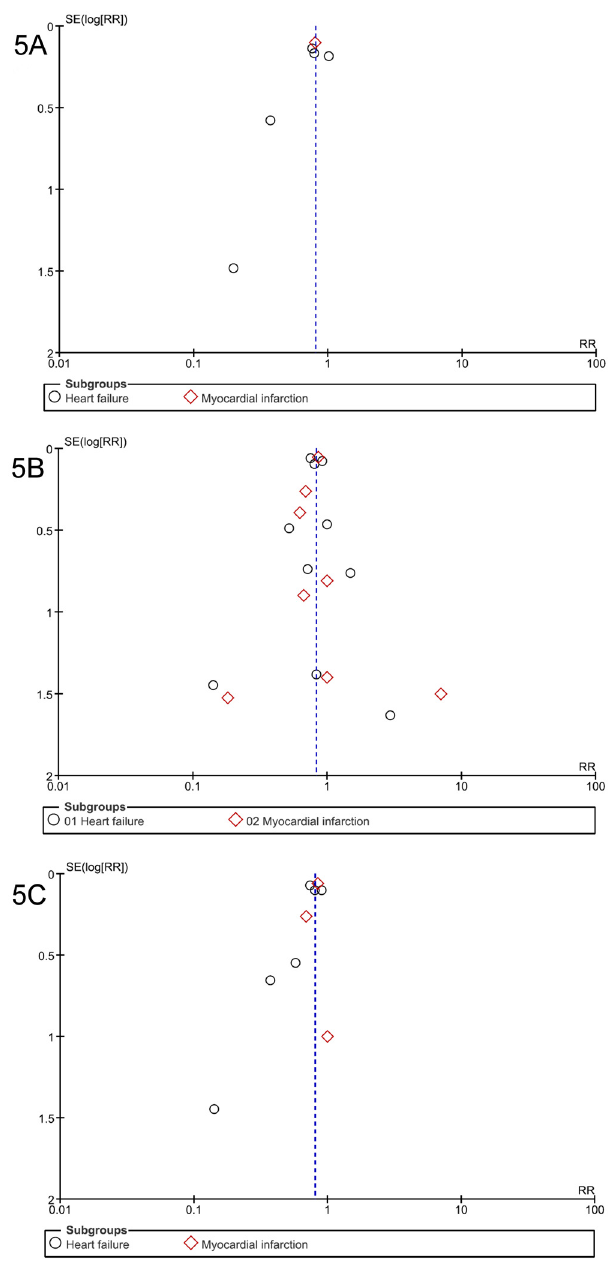
Fig 5. Funnel plot of standard error (log odds ratio) by odds ratio to evaluate publication bias for effect of aldosterone antagonist treatment in preventing (A) Sudden death, (B) All-cause mortality, and (C) Cardiovascular mortality in patients with heart failure or myocardial